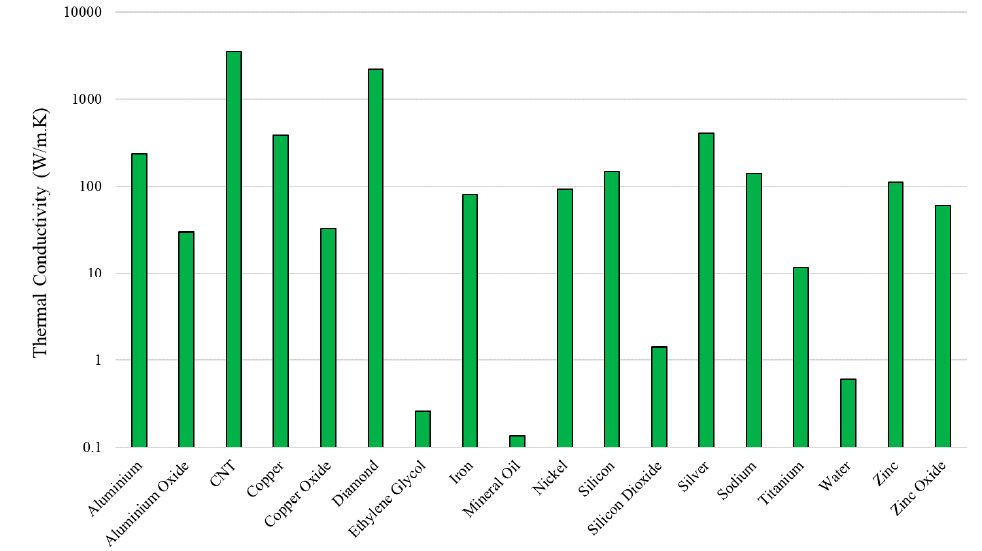
Figure 6. Comparison of thermal conductivities of metallic and non-metallic solids and liquids. Adapted from Kamatchi and Venkatachalapathy. Reproduced from [162], Elsevier: 2015.